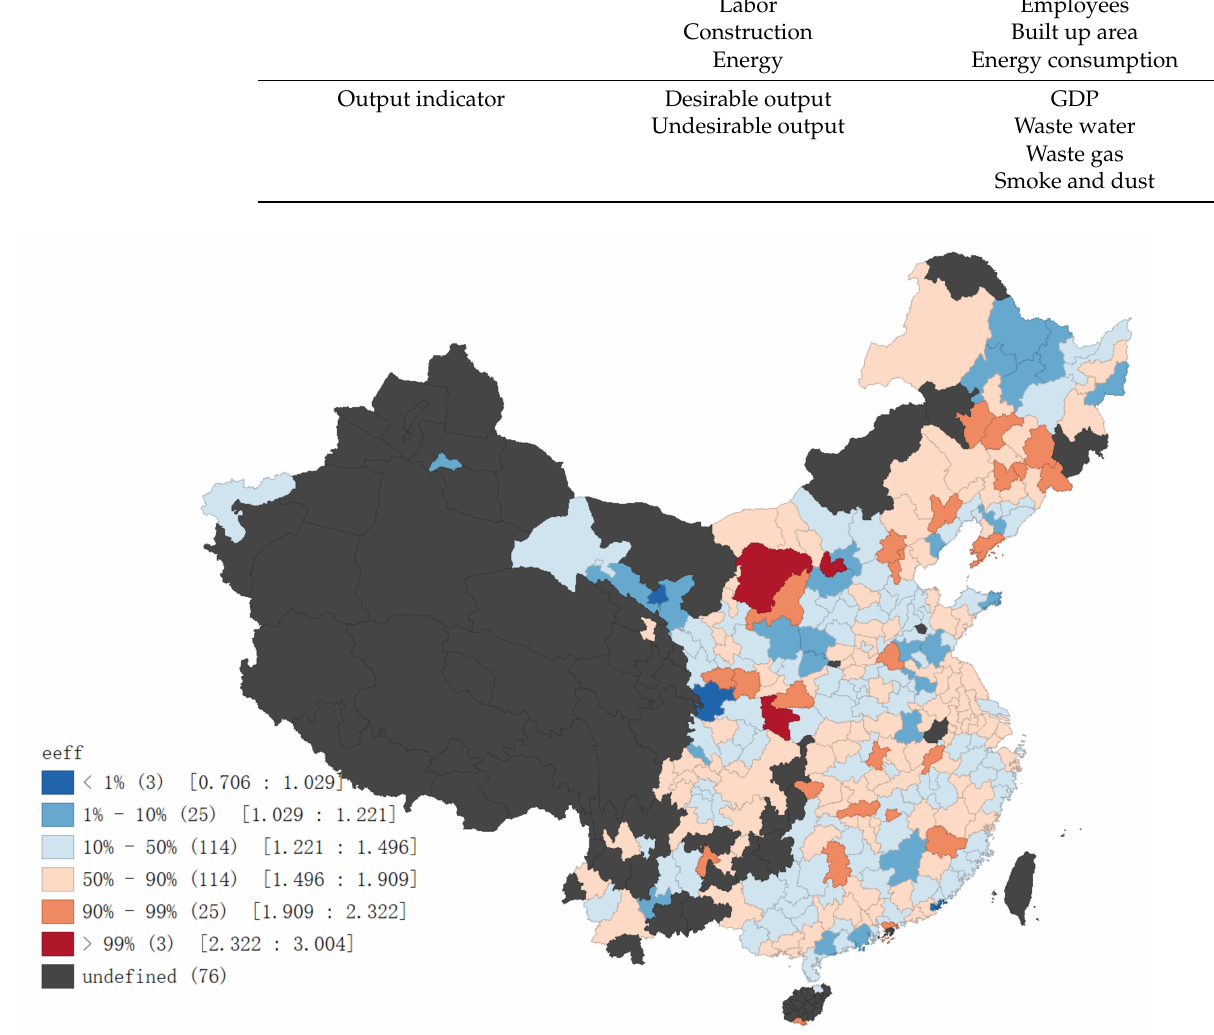
Figure 4. Mean e-eff values from 2008 to